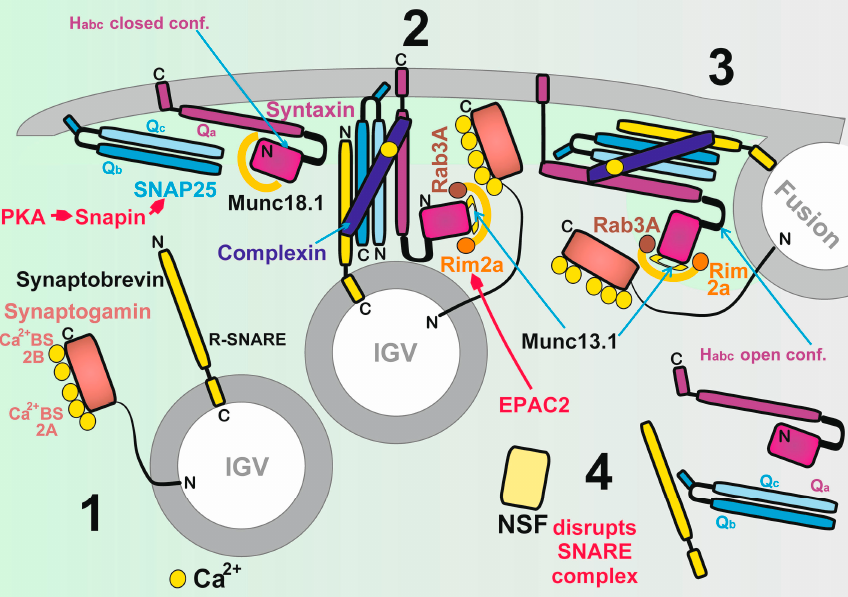
Figure 5. Mechanisms of insulin granule vesicle (IGV) exocytosis, schematically illustrated in four stages: Ca 2+ ions are depicted as yellow circles. C- and N-ends of proteins are marked and specific protein domains. Stage 1, when the Munc18.1 protein binds the Habc domain of syntaxin-1, locking it in the closed conformation. The elevated Ca 2+ promotes Ca 2+ binding to the synaptogamin C2 domains at the Ca 2+ binding sites 2B and 2A (“Ca 2+ BS 2B and 2A”) and to the C2 domain of the complexin. In stage 2, priming by the Rim2 α and Rab3A GTPases and their interaction with the Munc13.1 alters the syntaxin-1 conformation to the open one. This allows the formation of a large SNARE complex, the four-component bundle coiled-coil SNARE complex. In stage 3, SNARE complexes in a zippering fashion have enough energy to move the vesicle into close proximity to the plasma membrane and ensure fusion. At first, a fusion stalk (not shown) is formed followed by a larger septum until the content of the IGV lumen relocates to the outside of the cell. Along the pore expansion, the cis to trans conformation change of the SNARE complex takes place. In the terminating stage 4, the large SNARE complex is disrupted by the NSF ATPase. The verified PKA and EPAC2 targets are also shown. Note, that certain synaptogamin isoforms such as isoforms 4 and 8 do not bind Ca 2+ . If these were present in β -cells, this would allow IGV exocytosis at lower Ca 2+ concentrations. However, Ca 2+ would still be required for complexin.